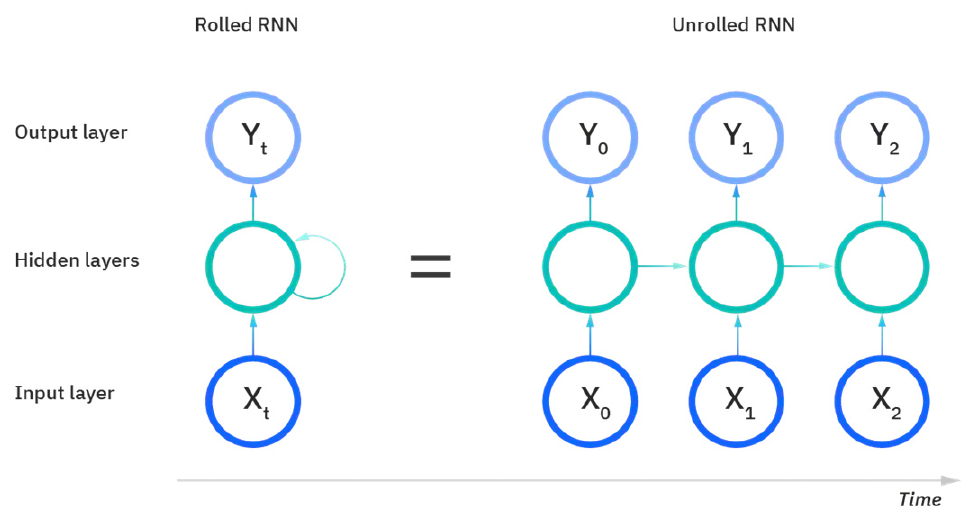
Figure 10. The rolled vs. unrolled visual of a Recurrent Neural Network (RNN) [24]. There are five types of recurrent neural networks that denote the number of input and output dimensions as illustrated in Figure 11a–e. One-to-one and one-to-many RNNs (Figure 11a,b) take a single input feature and perform processes to predict either one output or multiple different feature outputs respectively. The same could be said about the many-to-one and the many-to many variants of the RNN (Figure 11c,d), as they utilize more than one input feature to either predict an output for one desired feature, or output to many features either in a one-to-one input to output ratio or in a sliding window. The recurrent neural network models developed in this work are either the many-to-many or many-to-one variations, as multiple EEG signals are used as input to either predict a vectorization of the categorical patient age or the raw patient age. We utilize the Figure 11e model for predictions.